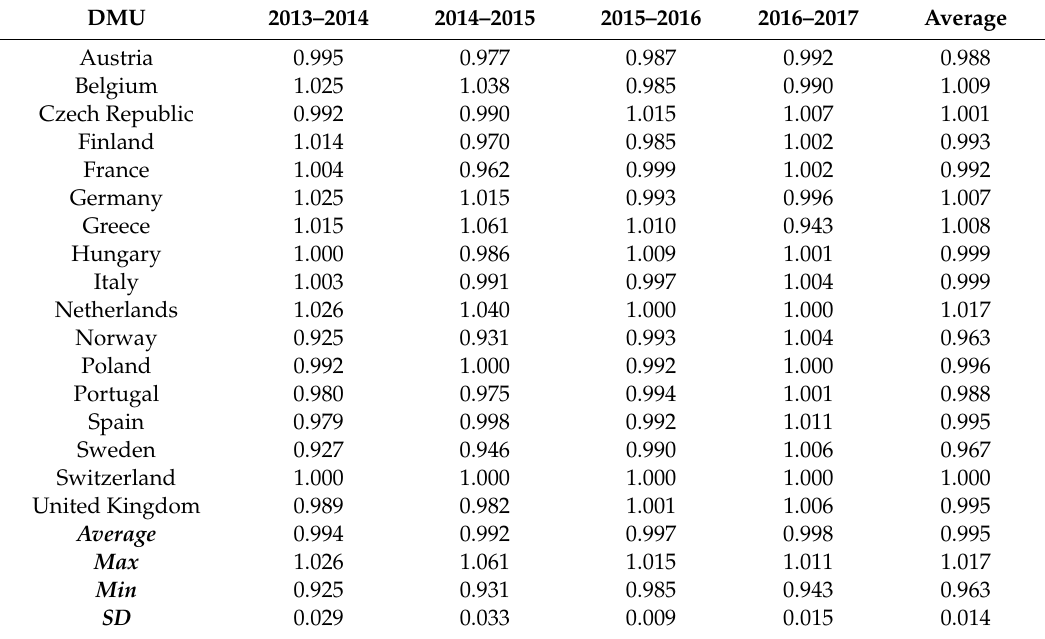
Table 7. Year-on-year e ffi ciency changes for the 17 DMUs from 2013 to